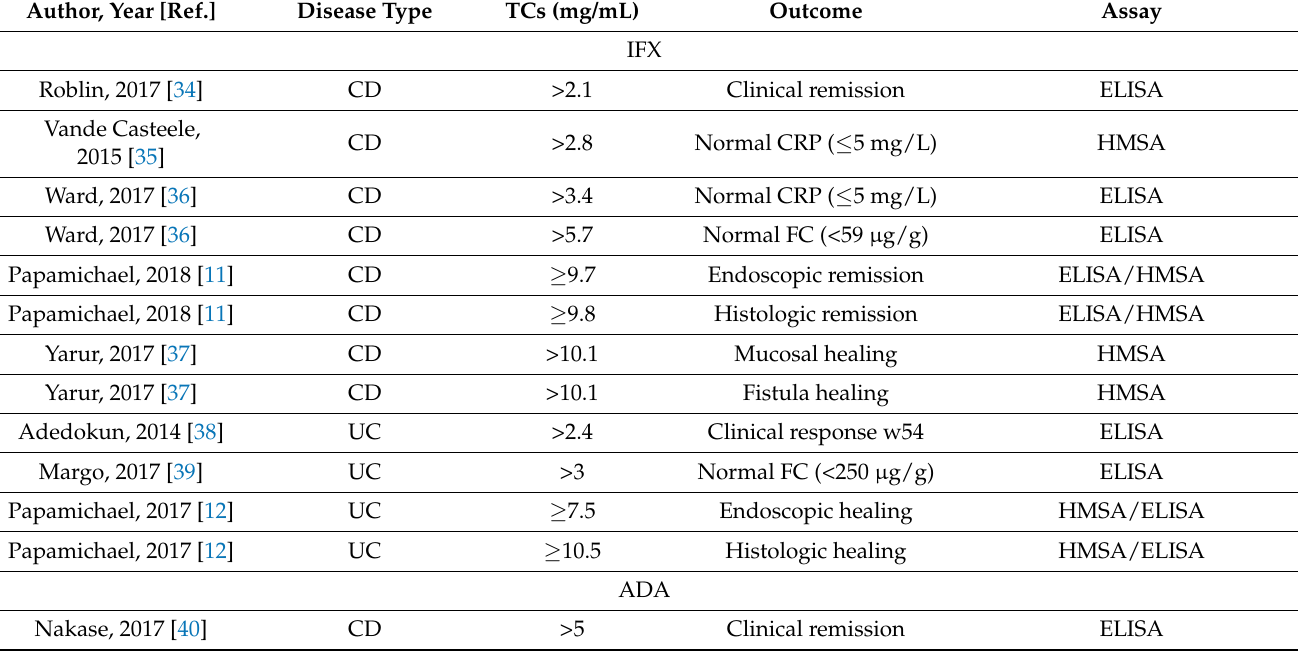
Table 2. Summary of most relevant and representative studies regarding TCs in the maintenance phase and their association with different